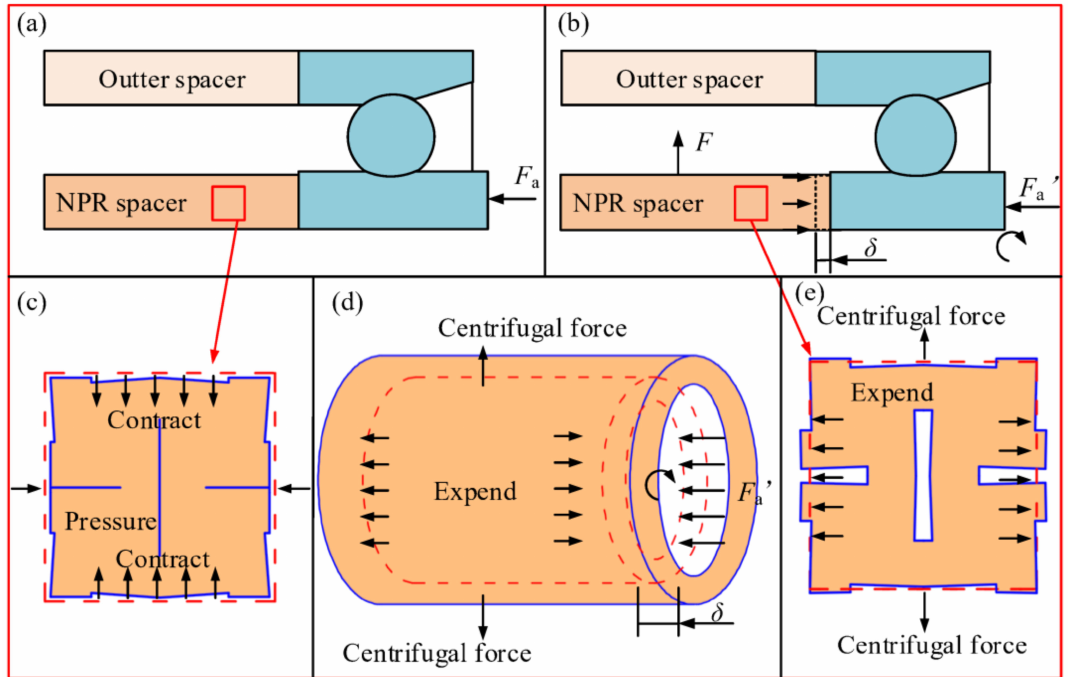
Figure 2. Principle of preload adjustment of NPR spacer. ( a ) Initial assembly stage of spacer, ( b ) Operation stage of spacer, ( c ) Cell contraction under compression, ( d ) Spacer expansion by centrifugal force, ( e ) Cell expansion under centrifugal